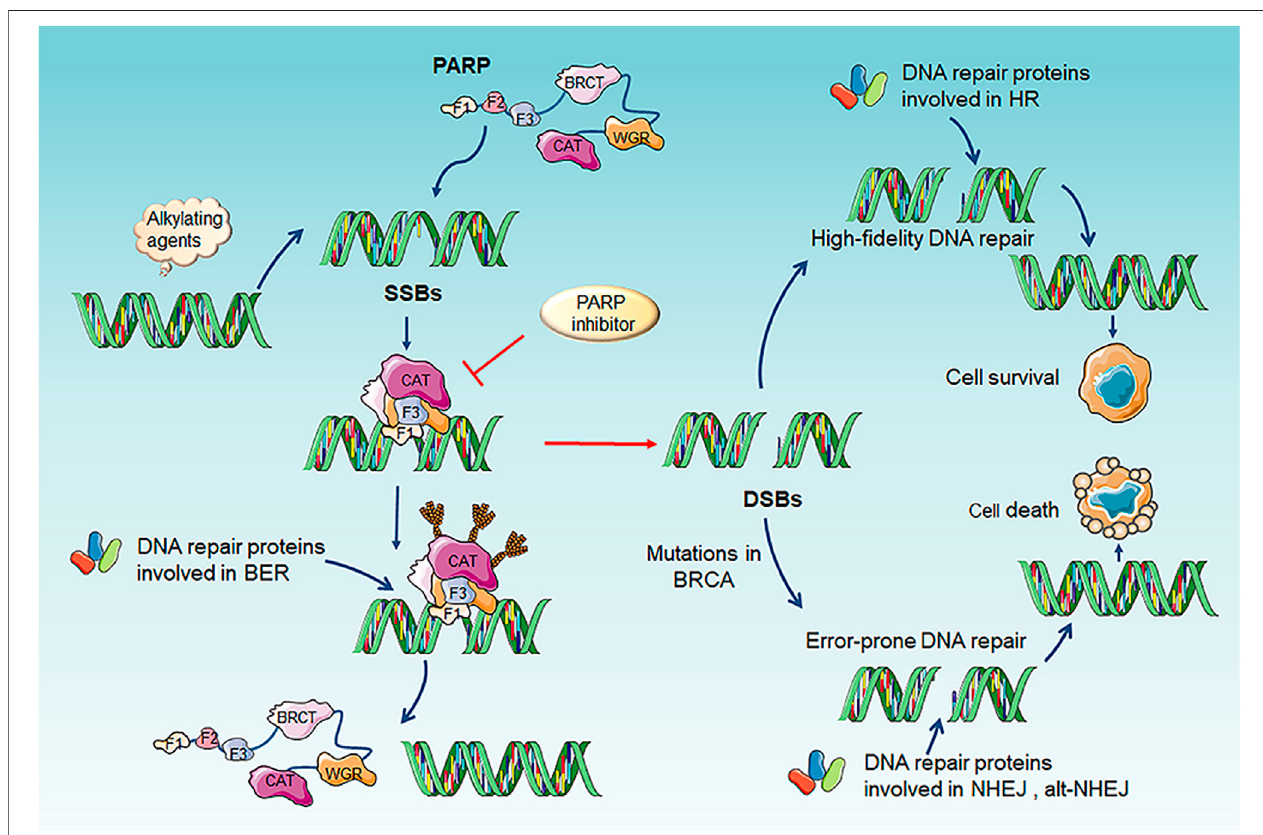
FIGURE 2 | Mechanism and function of PARP and PARP inhibitors. The catalytic function of PARP1 is activated through binding to the SSBs site cuased by alkylating agents. Activated PARP1 undergo PARylation and recruitment of a serials of key DNA repair effectors involved in BER to repair DNA lesion. Finally, PARP1 releasefromDNAandregaininactivestate.PARPinhibitorsbindsthecatalytic siteofPARPandimpairedoftheenzymaticactivityofPARPwhich “ trap ” PARP1onDNA, results in suppression of the catalytic cycle of PARP1 and BER. Trapping PARP1 on DNA lesion also collapses DNA replication fork, therefore transforming SSBs into genotoxic DSBs. This type of DNA lesion would normally induce HR for repairing damaged DNA. However, if HR-defective exist in tumor cells, including BRCA1/2 de fi ciencyormutation,anotherlesseffectiveanderror-proneDSBsrepairpathwayNHEJoralt-NHEJcouldbeutilized,whichcausinggenomicinstability,chromosomal fusions/translocations and subsequently inducing cell death. SSBs, single-strand breaks; DSB, double-strand break; BER, base excision repair; alt-NHEJ, alternative nonhomologous end joining; NHEJ, non-homologous end joining; HR, homologous recombination